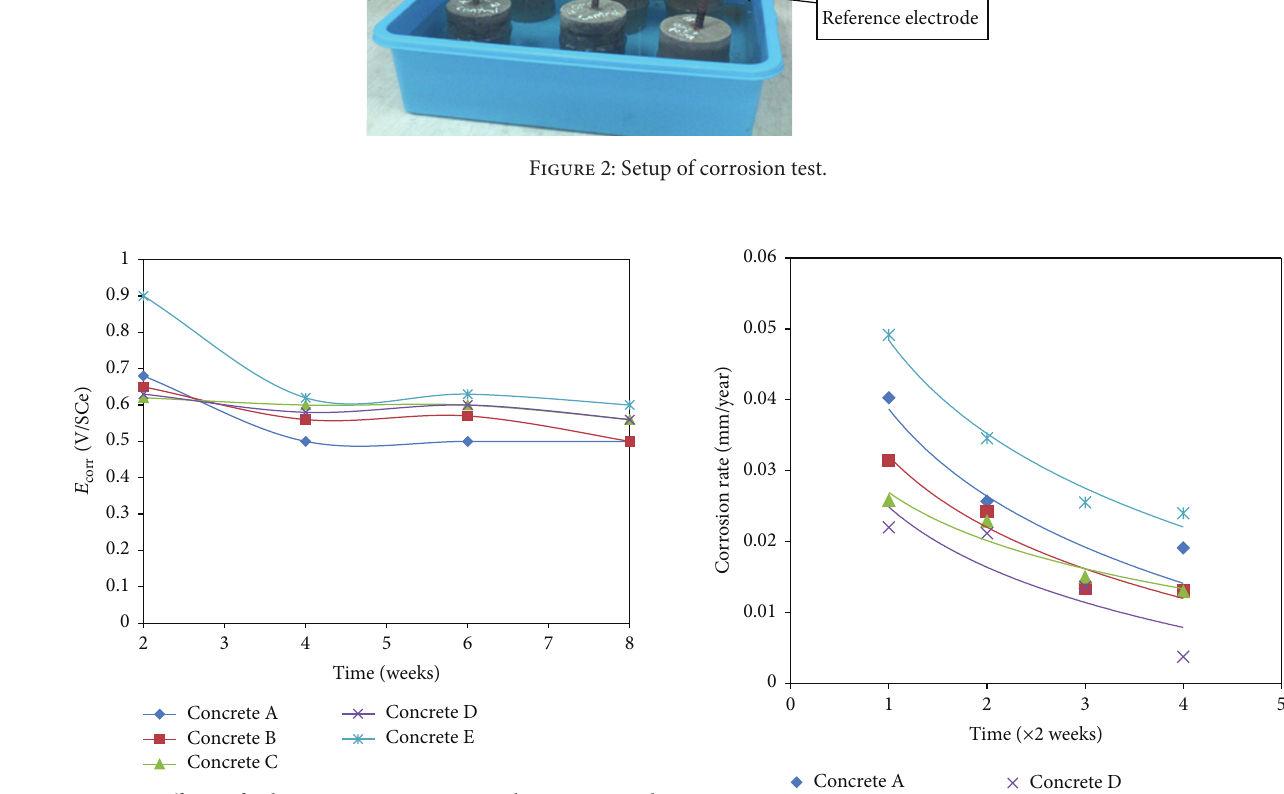
Figure 3: Effects of rebar on corrosion potential in 3.5% NaCl solution after immersion for 365 days.